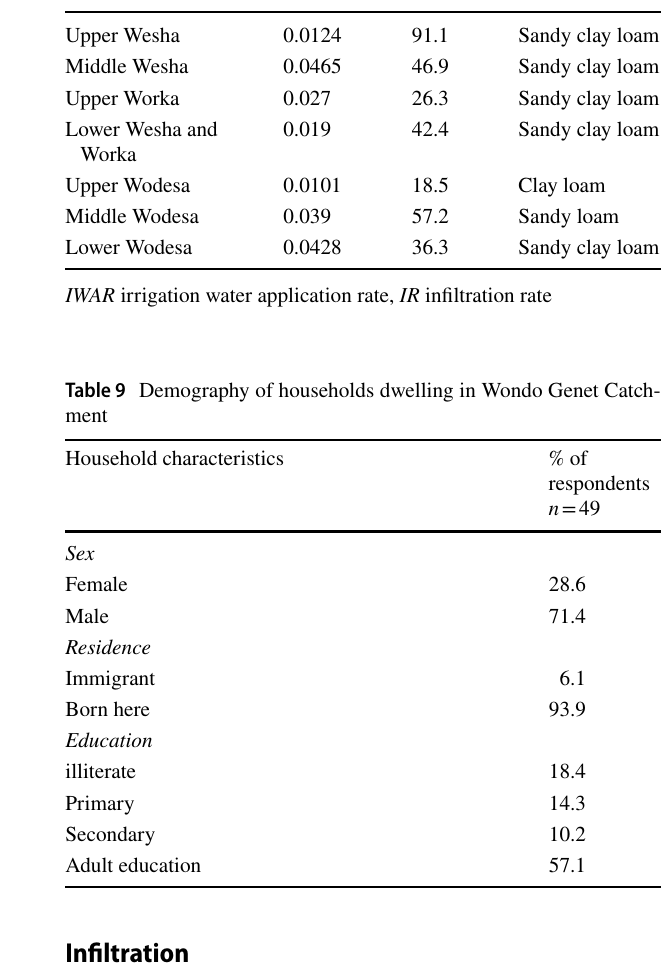
Infiltration Infiltration result indicates that the rate at which water enters into the soil. Actual soil intake rate has been compared with that applied by farmers. The minimum application rate esti- mated at upper irrigation area of Wodesa river 0.0101 m 3 /s (Table 8) could be 36.36 * 10 9 mm/h. Farmers were apply- ing irrigation water at the rate beyond intake capacity of the soil. Traditionalist of the system might influence but lack of know how have been highly aggravated such unexpected and problematic water application rates. Rates of irrigation water application should be according to soils intake rate. As illustrated by Savva and Frenken (2002), infiltration rate is highly influenced by the soil textural class. Infiltration rate of greater than 30, between (20–30, 10–20 and 5–10), and less than 5 mm/h were reported for sandy, sandy loam, loam, clay loam and clay textural classes, respectively (Dagadu and Nimbalkar 2012).